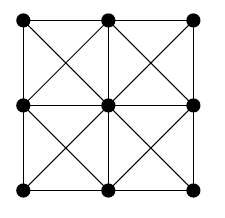
Figure 3: The graph H (cid:48) obtained by clique expansion of H in Figure 1. The transport by W 1 follows this graph structure.